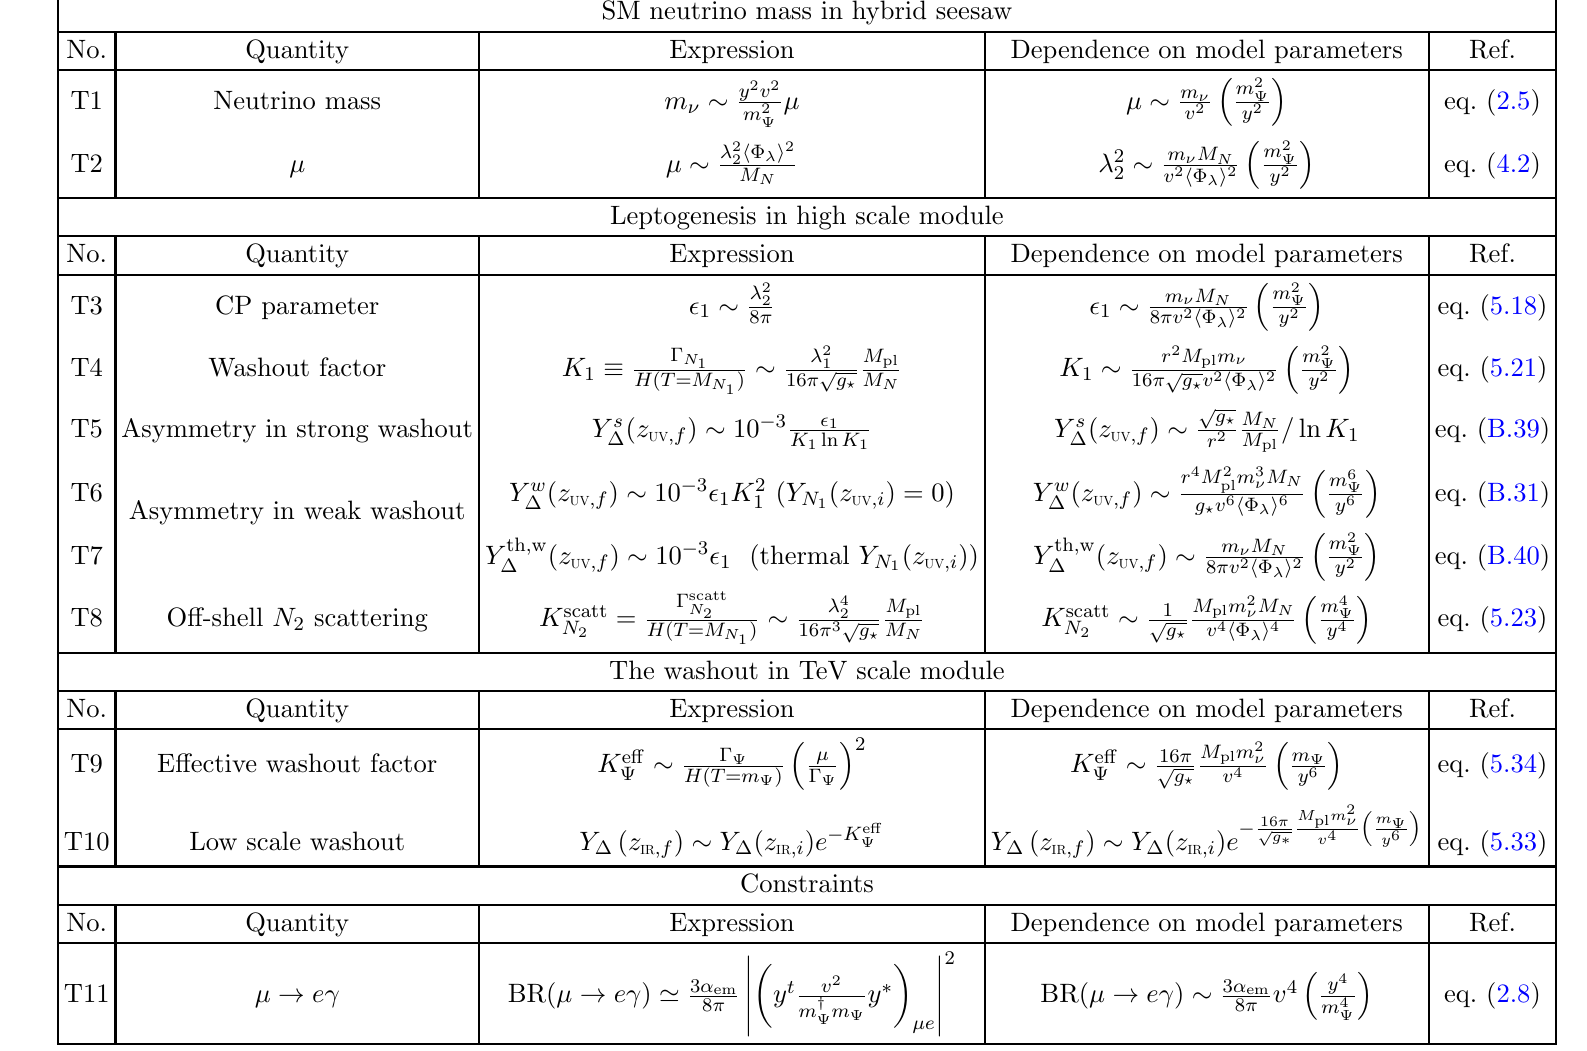
Table 4 . Summary of formulae for hybrid-leptogenesis with r assume that M N